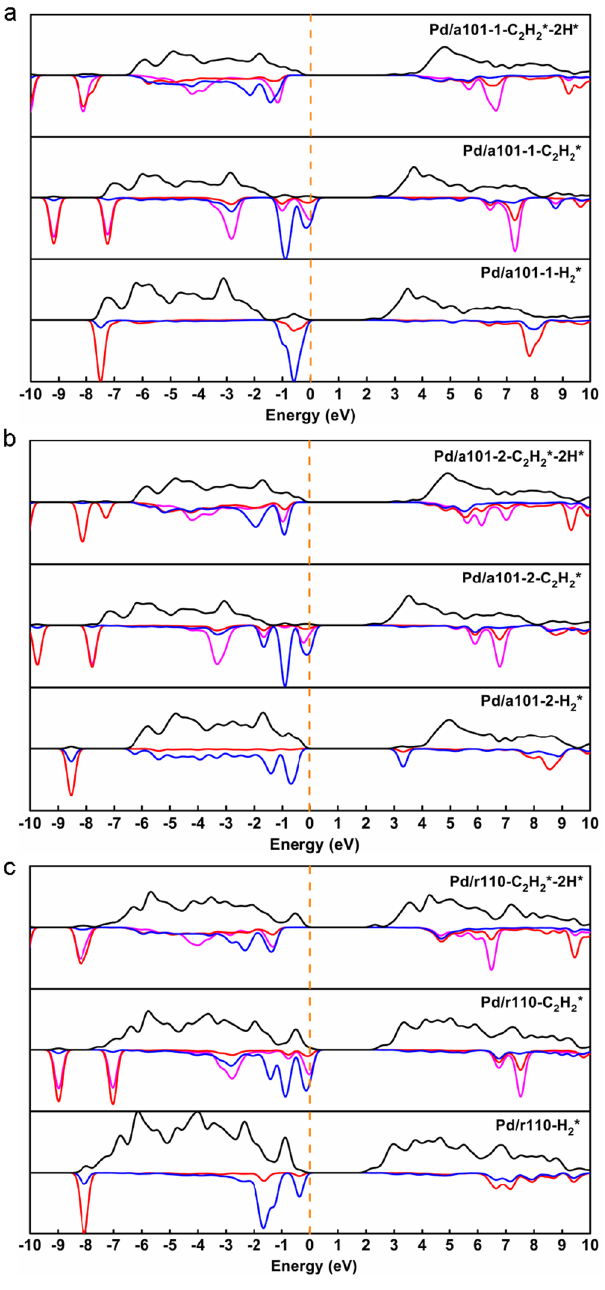
Fig. 5 Projected density of states (PDOS) of ground states of nine adsorbed structures on catalysts. a Pd/TiO 2 -a101-1. b Pd/TiO 2 -a101-2. c Pd/TiO 2 -r110. Density of states that projected onto different kinds of atoms are drawn with different color: C: pink, H: red, Pd: blue, Total DOS: black. Fermi level has been shifted to 0 eV and marked by orange dashed